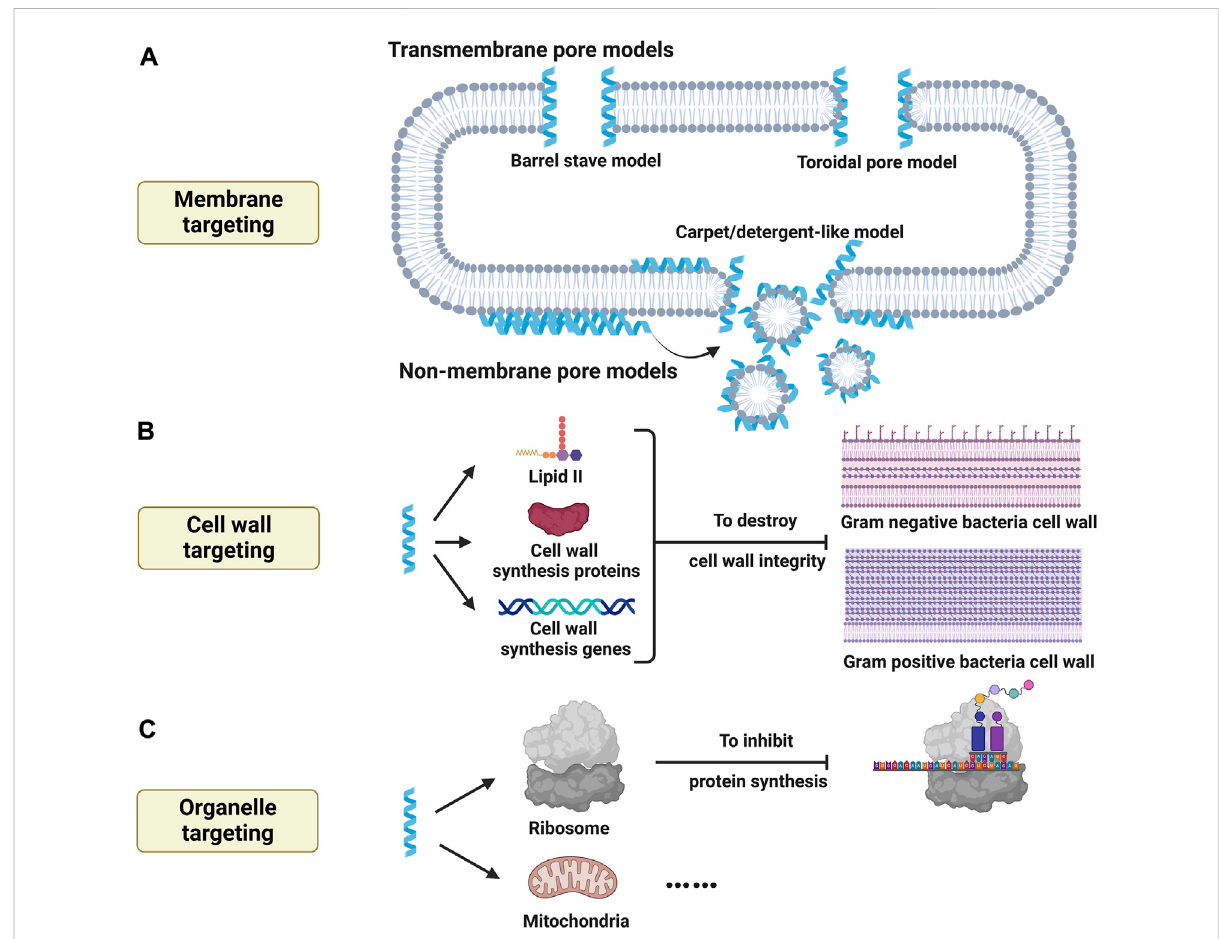
FIGURE 4 Bactericidal activity of antimicrobial peptides by targeting cell structures. (A) Antimicrobial peptides target to cell membrane to induce membranelysisbytransmembraneporemodels(barrelstavemodel,toroidalporemodel, etc. )andnon-membraneporemodels(Carpet/detergent- like model, etc. ). (B) Antimicrobial peptides target cell wall synthesis and in fl uence cell wall integrity by binding to lipid II, modulating cell wall synthesis related proteins and genes. (C) Antimicrobial peptides target organelles to in fl uence physiological activities of microorganisms, thus exerting bactericidal effects. Created with